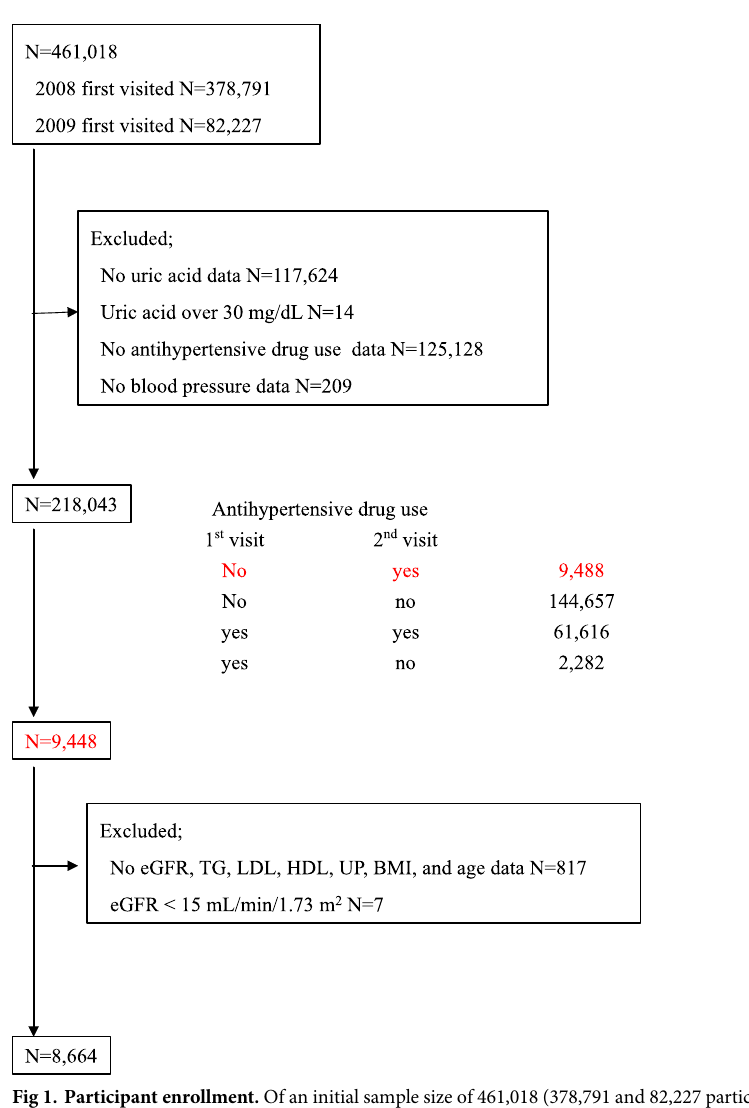
the American Diabetes Association guidelines [22] as fasting plasma glucose � 126 mg/dL, gly- cated hemoglobin � 6.5%, or self-reported use of antidiabetic medications. Hypertension was defined as SBP � 140 mmHg, BDP � 90 mmHg, or self-reported use of antihypertensive medi- cations. Dyslipidemia was defined according to the Japan Atherosclerosis Society guidelines [23] as LDL � 140 mg/dL, HDL < 40 mg/dL, TG � 150 mg/dL, or self-reported use of anti-dys- lipidemic medications.